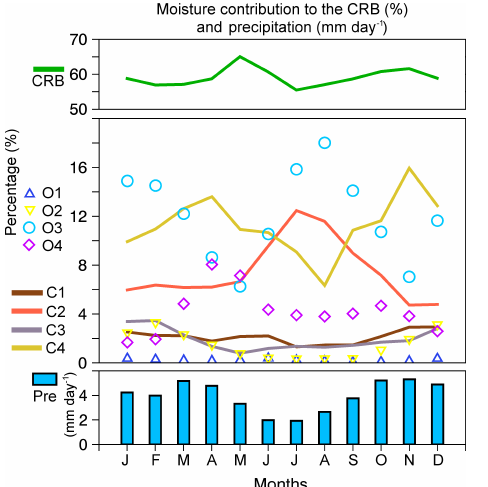
Figure 8. Monthly percent of moisture loss, which is calculated as | ( E − P ) i 10 < 0 | forward-integrated from each source over the CRB over 10 days of transport, and the monthly mean precipitation from the CRU datasets for the period